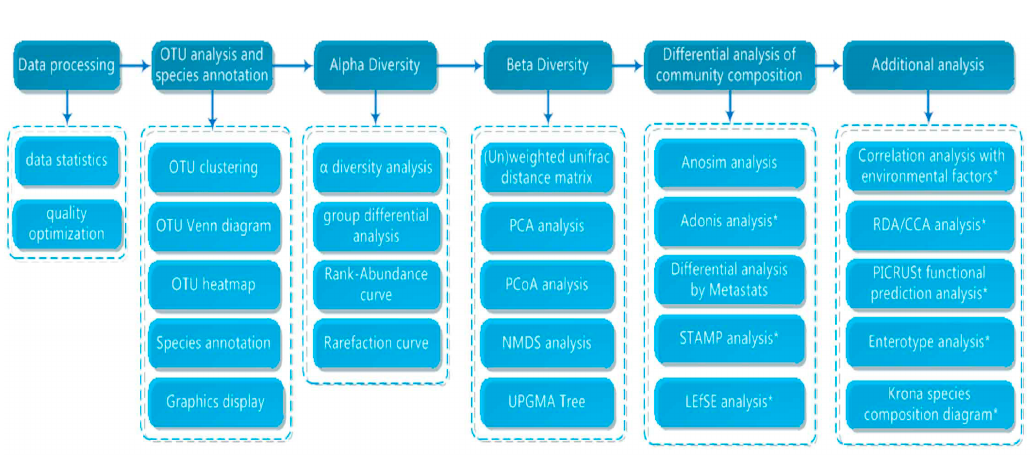
Fig. 2. Microbial diversity data analysis workflow